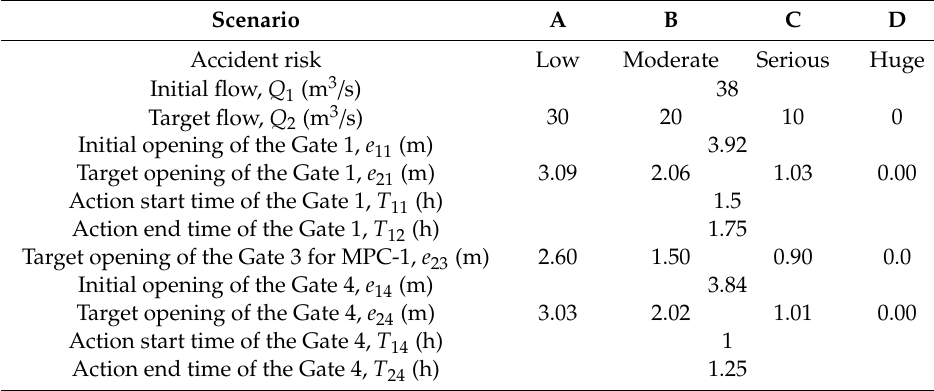
Table 5. Control parameters of test scenarios.